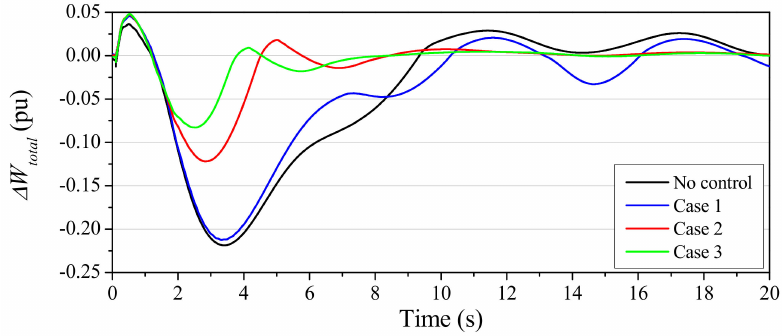
Figure 17. ∆ W total : deviation of summation of kinetic energy of each SG (with PV system installed).